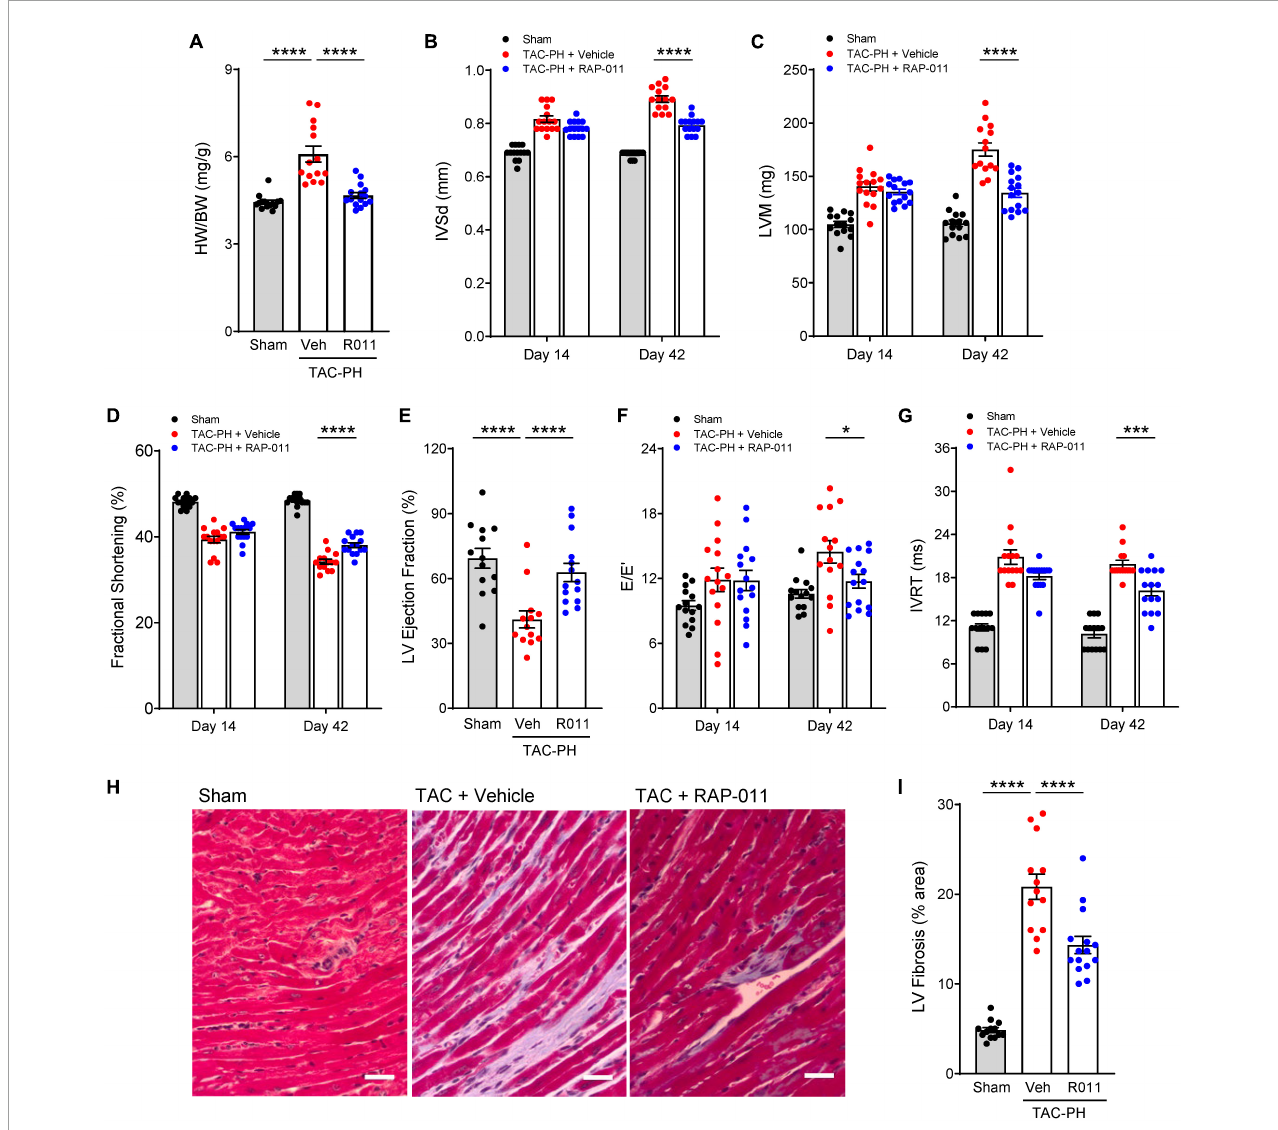
FIGURE3 ActRIIA-Fc reduces left ventricle (LV) remodeling and improves left heart function in the TAC-PH mouse model. (A) Heart weight normalized to body weight (HW/BW), (B) interventricular septum thickness in diastole (IVSd), (C) LV mass (LVM), (D) fractional shortening, (E) LV ejection fraction, (F) mitral inflow velocity (E) and mitral annular velocity (E’) ratio (E/E’), and (G) isovolumic relaxation time (IVRT). Data are means ± SEM ( n = 10–15 mice per group for day 42). (H) Representative images of LV sections stained with Masson’s trichrome blue to detect fibrosis (scale bar, 50 µ m) and (I) quantification of percentage area occupied by fibrotic tissue. Data are means ± SEM ( n = 10–15 mice per group). Analysis by one-way ANOVA and Dunnett’s post-hoc test (* P < 0.05, *** P < 0.001, **** P < 0.0001). RAP-011 (R011), vehicle (veh,